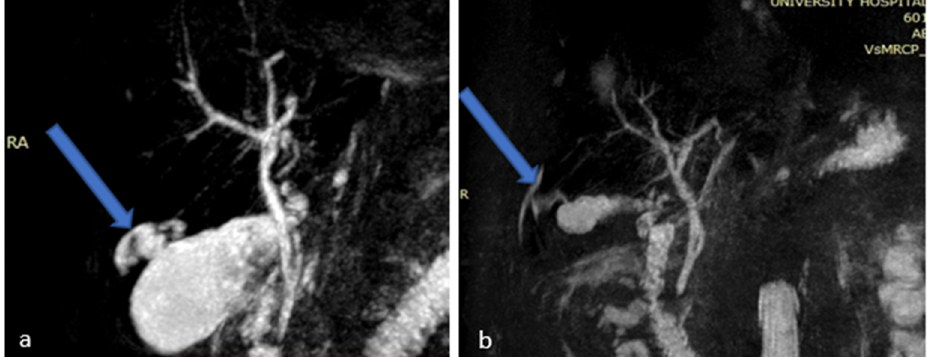
Figure 2. Magnetic Resonance Cholangiopancreatography (MRCP) images ( a , b ) showing gallbladder perforation (blue arrows).